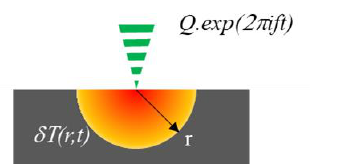
Fig. 2. Schematic representation of the spatio-temporal evolution of the temperature in a material for a source point on the surface with an intensity modulated source.